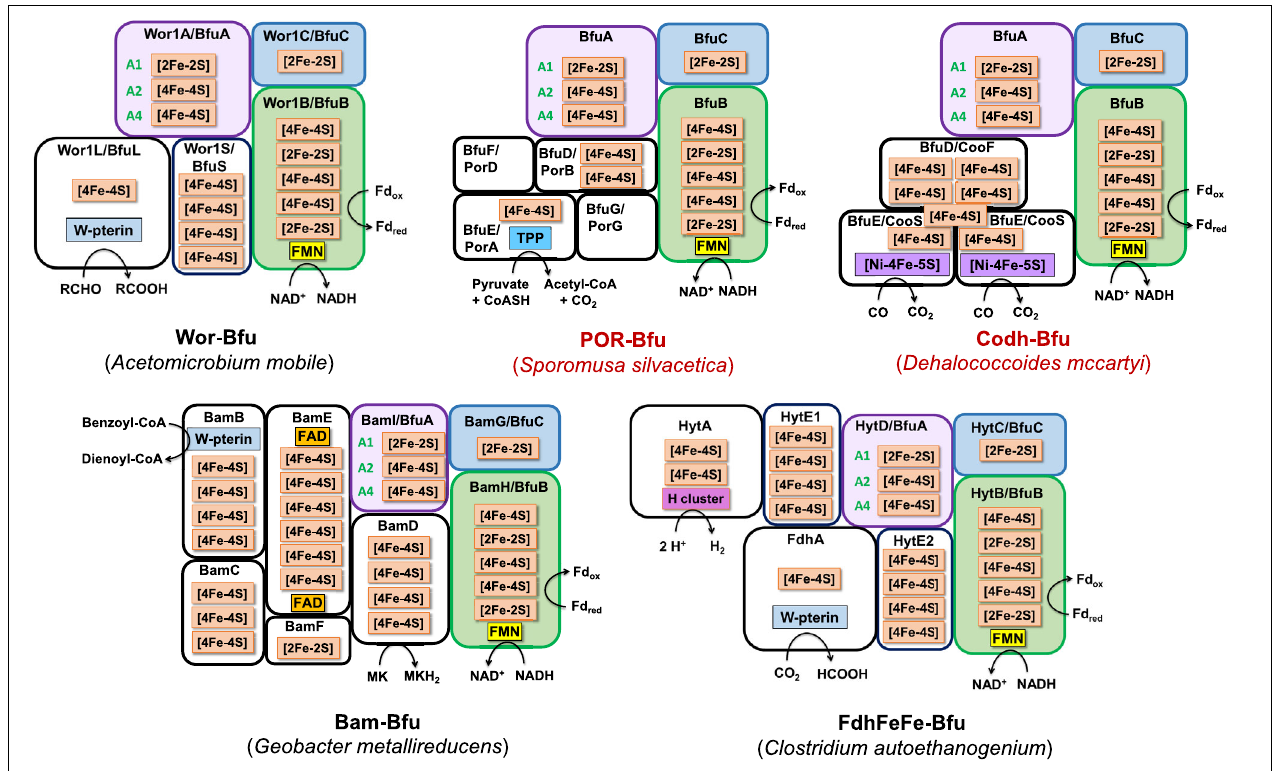
FIGURE 7 | Predicted subunits and cofactor contents of Type 2 Bfu enzymes. Characterized and predicted enzymes and their microbial sources are shown in black and red font, respectively. These enzymes contain additional subunits that feed electrons to BfuA from the third substrate. Their BfuA subunits lack the A3 and A5 iron sulfur clusters. See text for